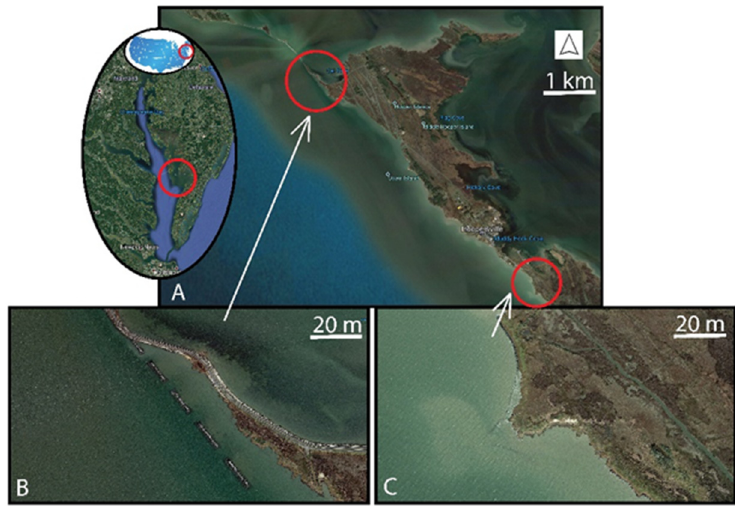
Figure 11. Example of failing breakwaters use in Chesapeake Bay, US. ( A ) Eastern Shore of Maryland, (Hoopers Island), ( B ) and ( C ) shows failing coastal structures like breakwaters and submerged Riprap. Signs of erosion are evident in the back-marsh area.